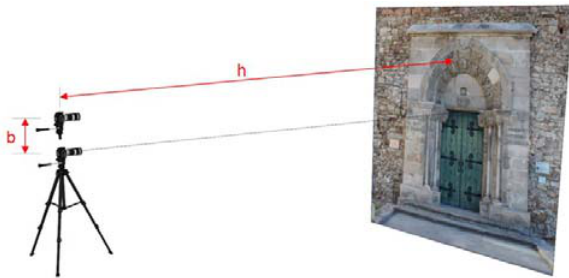
Figure 1. Ratio “b/h” in a tripod placement centered relative to the object, to obtain a vertical pair of images.